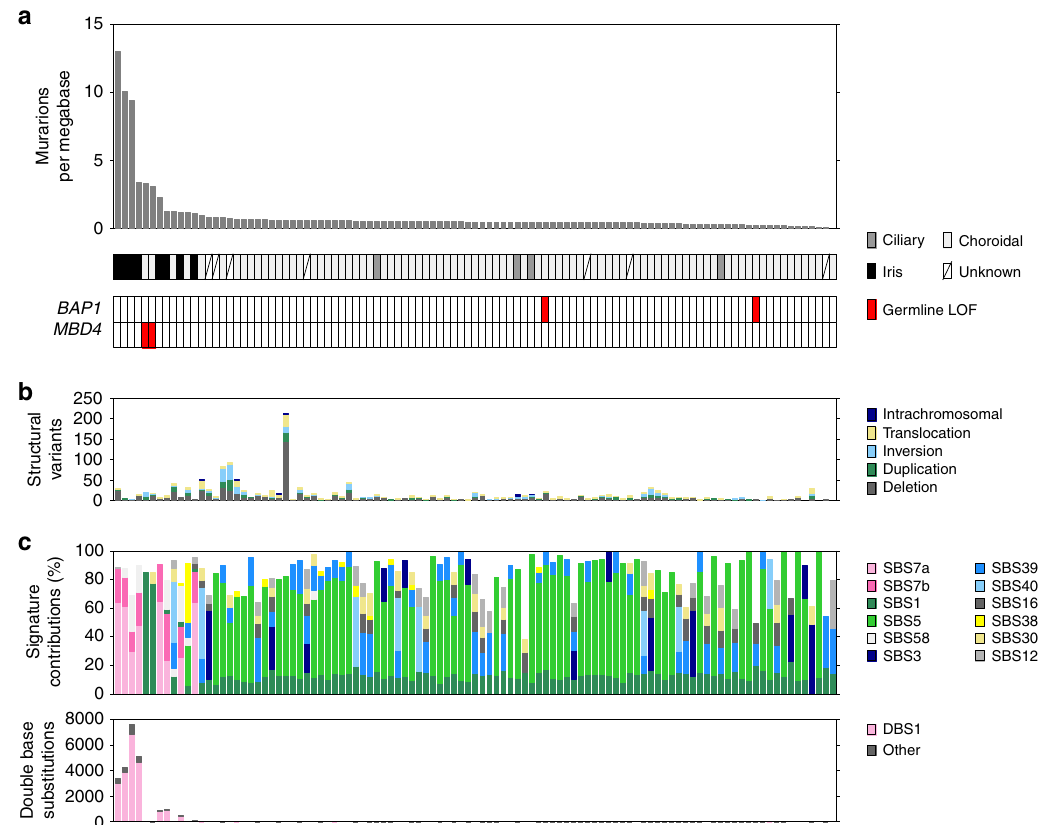
Fig. 1 Mutational landscape of 103 UM tumours. a Tumour mutation burden (substitutions and indels) in 103 uveal melanomas. b Burden of structural variation in each tumour displayed as numbr of events. Variants are coloured according to their event category. One outlier was observed with >200 events, mostly mid-sized (<100 kb) deletions. c Spectrum of single base substitution (SBS) signatures shown as percentage. Most samples were dominated by signature 5, which has been observed in most cancers. Signatures SBS7a and SBS7b, only seen in iris melanomas here, are commonly observed in cutaneous melanoma and associated with exposure to ultraviolet radiation (UVR). SBS1 was predominantly observed in melanomas with loss of MBD4 and is associated with deamination of 5-methylcytosine. Spectrum of double base substitutions shown as number of substitutions in each tumour. DBS1 is characterised by CC>TT transition and associated with exposure to